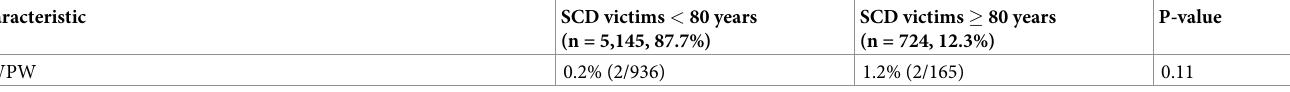
Autopsy findings/characteristics Four-fifths (82.2%) of the ischemic SCD victims � 80 years had � 75% stenosis in one major coronary artery measured in the cross-sectional area, whereas 76.2% of the ischemic SCD victims < 80 years had � 75% stenosis (P = 0.001) (Table 1).